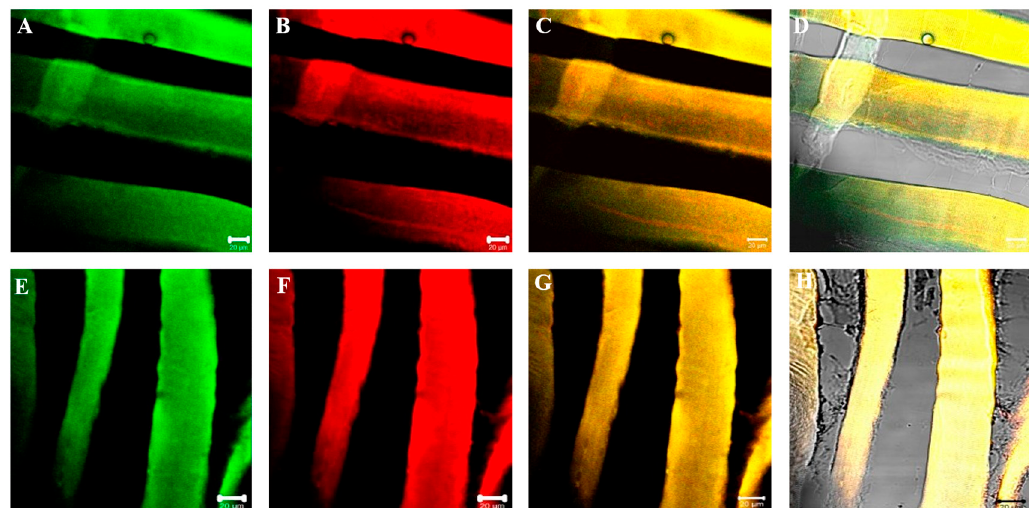
Figure 4. Compound panel of double immunofluorescence reaction between alpha-SG (green channel) and beta-dystroglycan (red channel) ( A – D ) and between gamma-SG and beta-dystroglycan ( E – H ) performed on sternocleidomastoid of high-ranking baboons. Results show that both alpha- and gamma-SGs and beta-dystroglycan are expressed along all observed muscle fibers. The yellow fluorescence arises from the merge between green and red fluorescence. The transmitted light shows that all the fibers in the microscopic field are positive for the tested proteins ( D , H ). The same data have been found for all the SG isoforms.